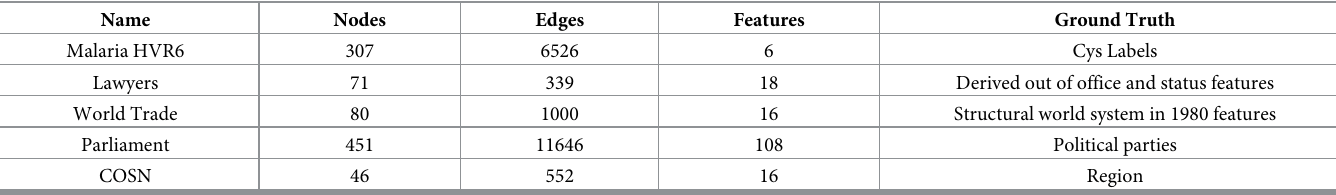
Table 1. Real world datasets under